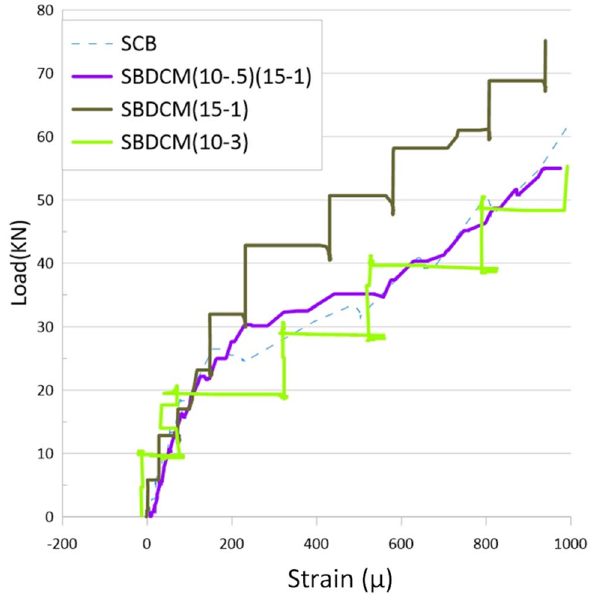
Fig. 13 Load–strain curves for three specimens compared to those of the control beam